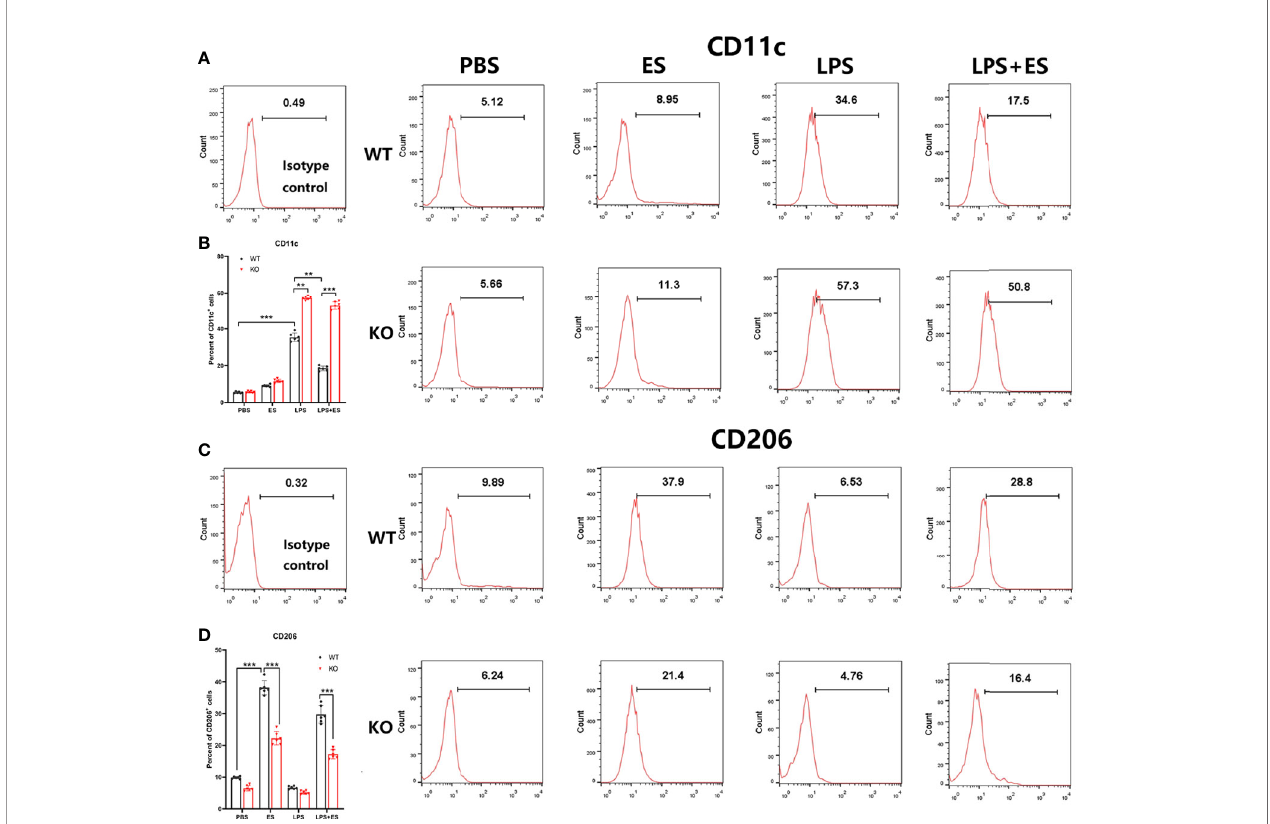
FIGURE 2 | Expression of CD11c (M1 marker) and CD206 (M2 marker) on wild type (WT) or Nrf2 KO macrophages induced by T. spiralis ES. The stimulated macrophages were stained PE-conjugated mAbs to CD11c (A, B) or CD206 (C, D) , and analyzed by fl ow cytometry. Data are showed by the mean ± SD of each group (n=6) **P < 0.01, ***P < 0.001, ns, no signi fi cance, as indicated by the line (one-way ANOVA with Tukey ’ s post hoc